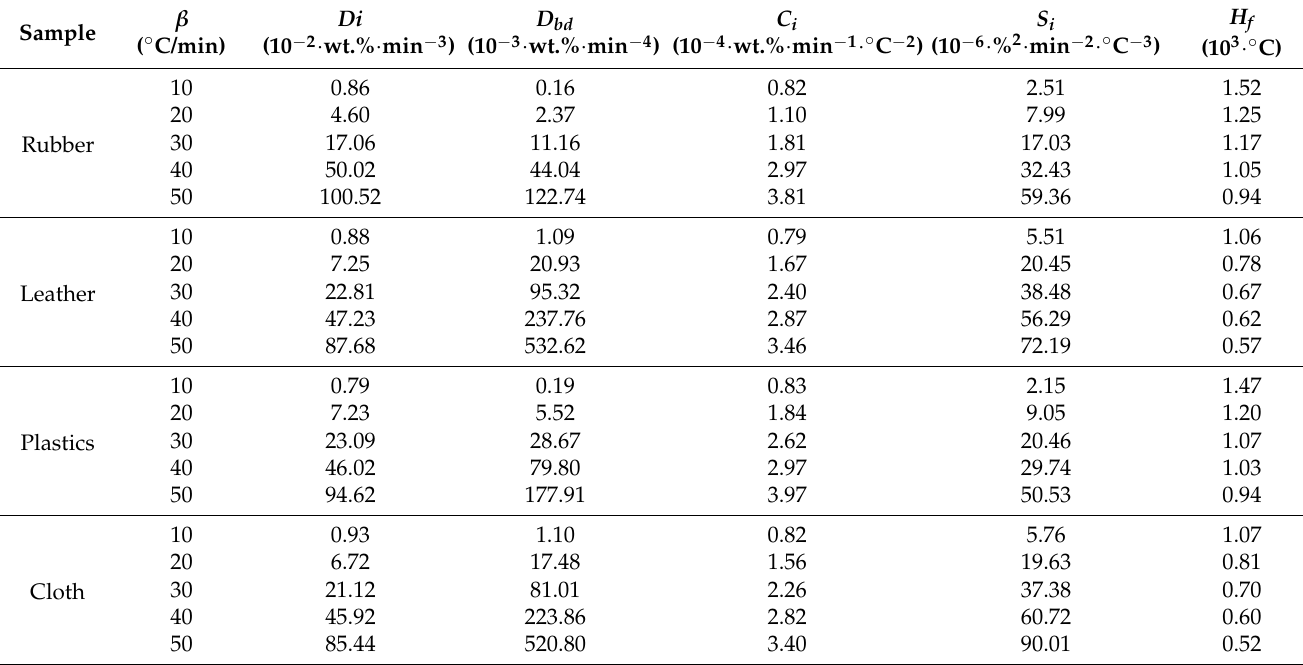
Table 2. Quantitative comprehensive combustion parameters of four polymeric waste polymers at different heating